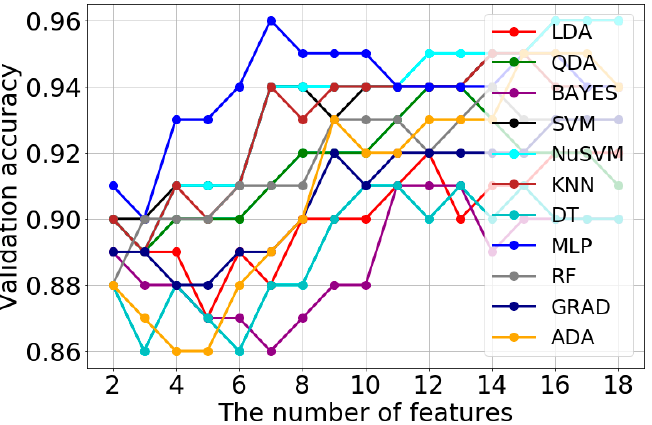
Figure 4. Exemplary process of the model learning and validation for a set of features obtained with the Fisher method (soft-tissue reconstruction) for different classification methods. The graph shows that—for instance—the optimal number of features for the MLP model is 7. Table 1. Results of hyperparametric optimization with the grid search method for the set of features obtained with the Fisher method (soft-tissue reconstruction). The criterion assumed for the selection of an optimal model for a given classification method involved achieving maximum validation accuracy with minimum number of training set features. The grey background was used to emphasize the model, which proved the best among the employed classification methods for the Fisher method. The meaning of parameters of individual classification models can be found in the scikit-learn library documentation [44].